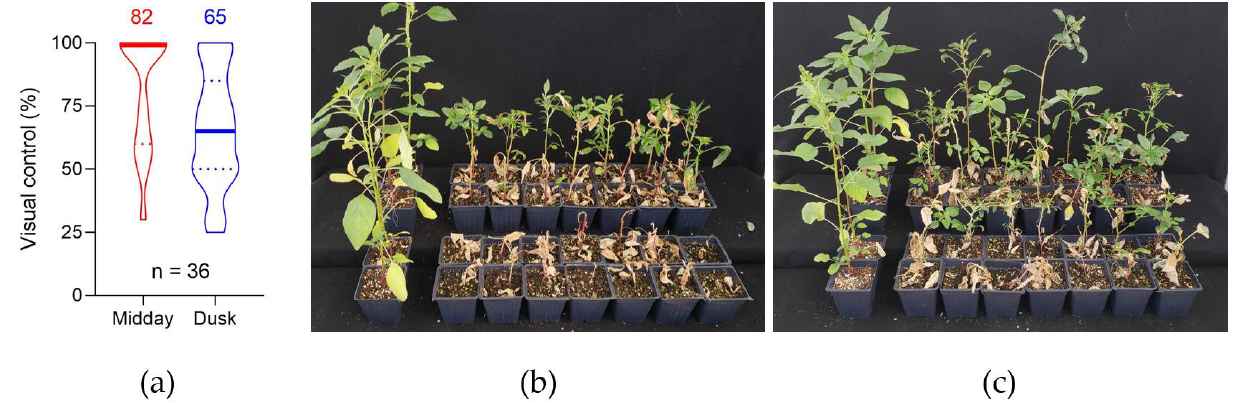
Figure 1. Violin plot ( a ) for % visual control of Amaranthus palmeri by glufosinate application (140 g ha −1 ) at midday (red) vs. dusk (blue). Pictures representing plant response to glufosinate application at midday ( b ) vs. dusk ( c ). Bold lines in the violin plot indicate the median, whereas the dashed lines represent the 95% confidence interval. Control plants are on the left side of each picture.